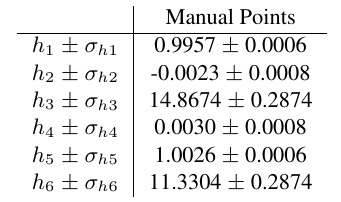
Table 2: Estimated affine parameters for LiDAR DSM and HSI with manual selected tie points.